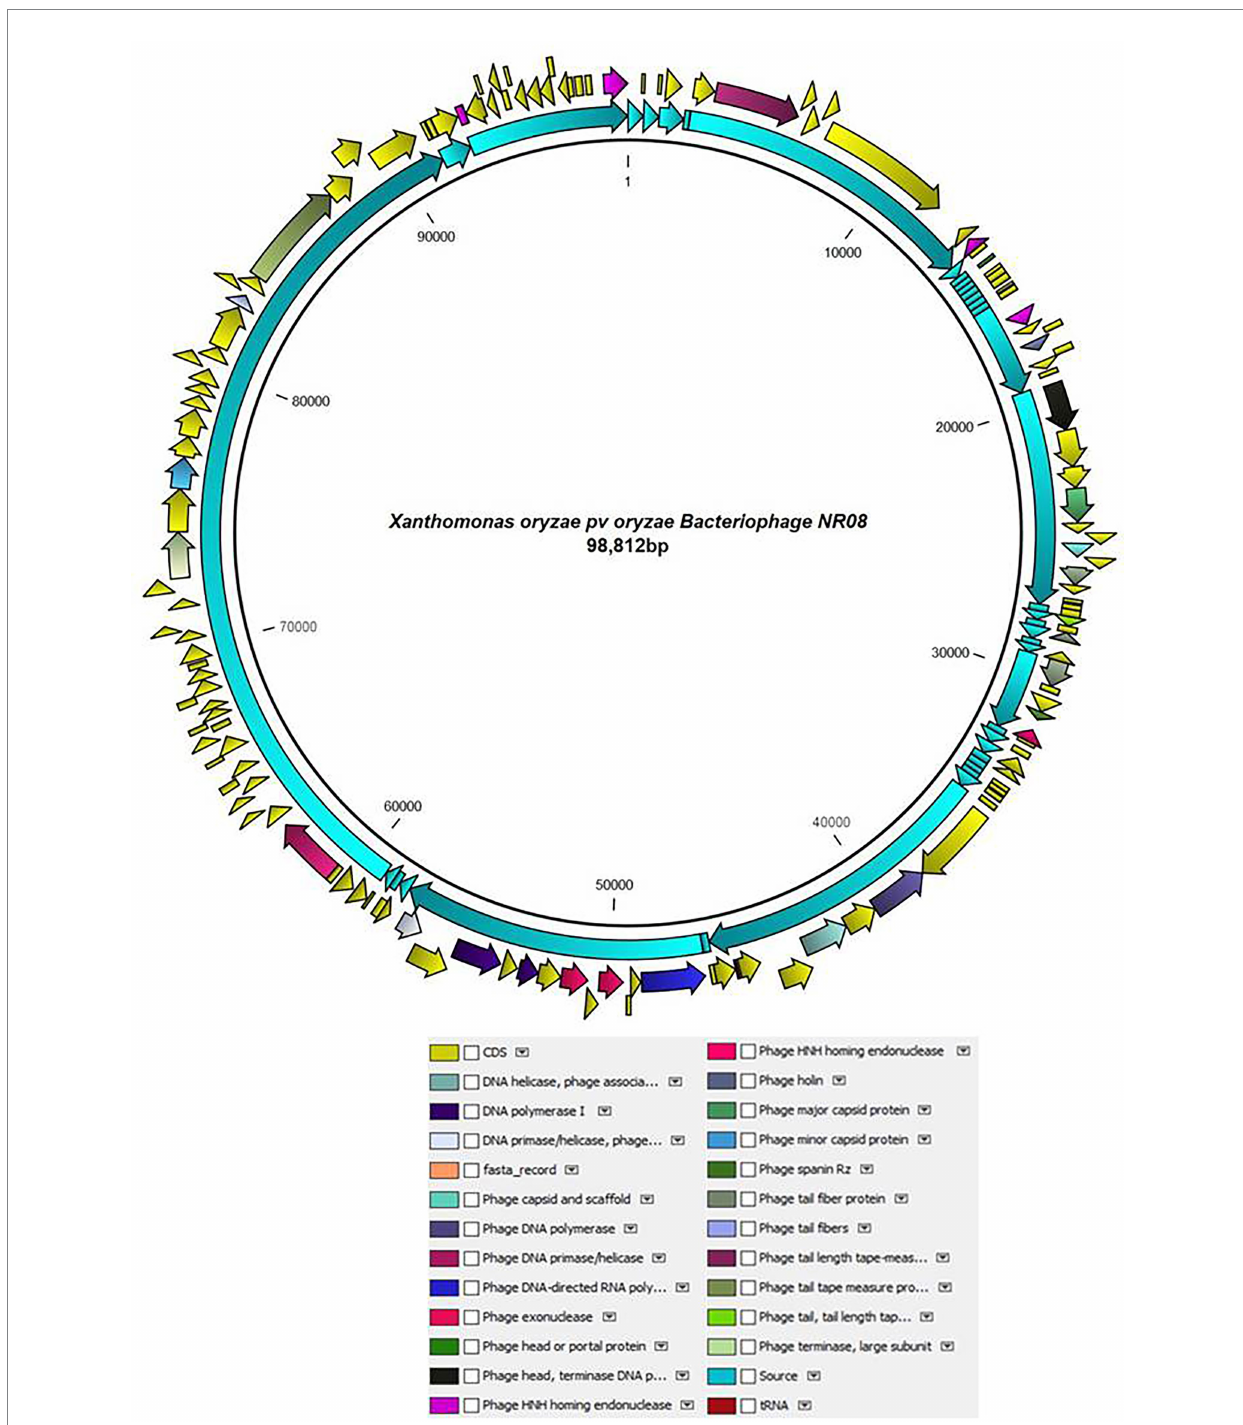
FIGURE 6 Schematic diagram representing the genome of NR08 phage with the functionally annotated ORF having four different modules of proteins: DNA packaging module, morphogenesis module, DNA replication module, and lysis